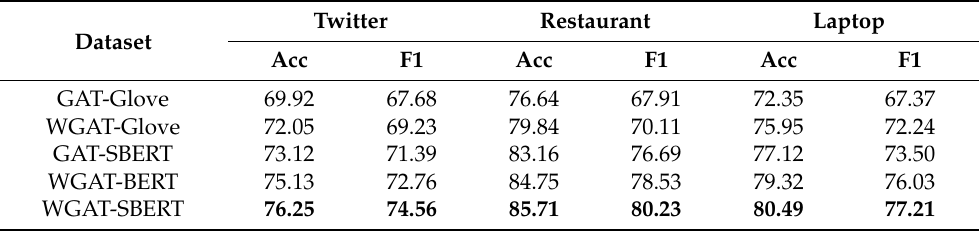
Table 4. Ablation